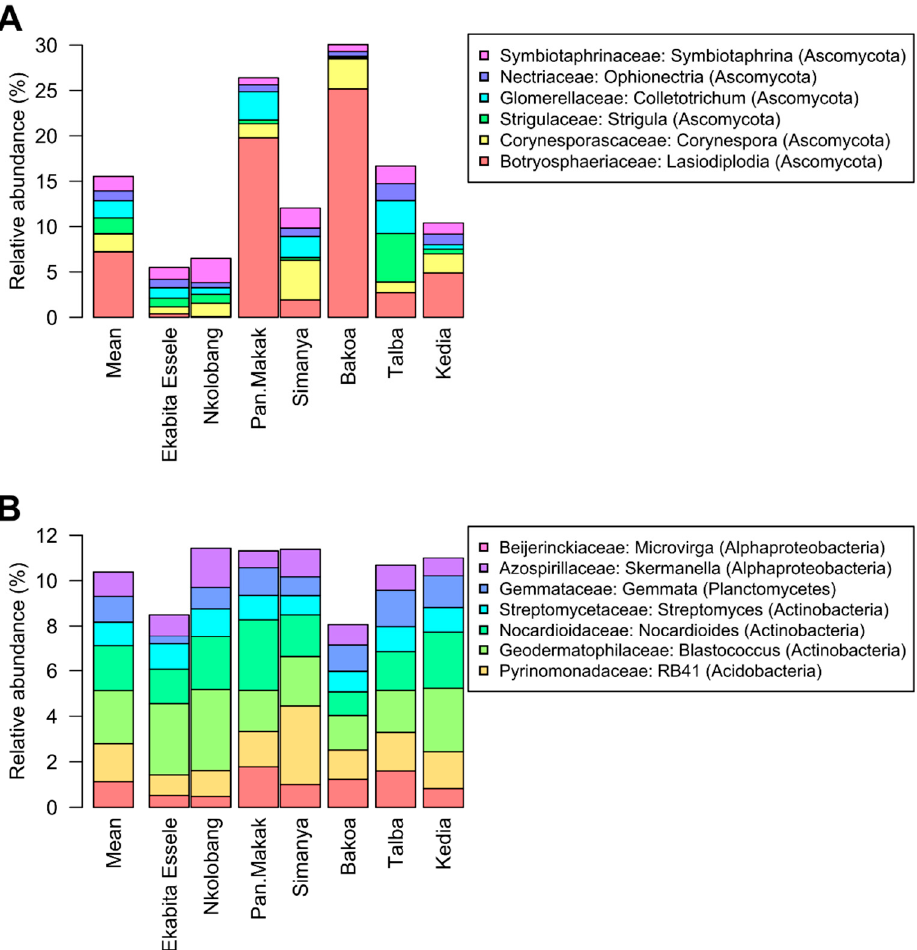
Figure 3. Abundant fungal ( A ) and bacterial ( B ) genera in T. cacao leaves collected in seven di ff erent agroforestry management systems in Cameroon. Only genera with an average abundance ≥ 1% in the entire data set are shown.